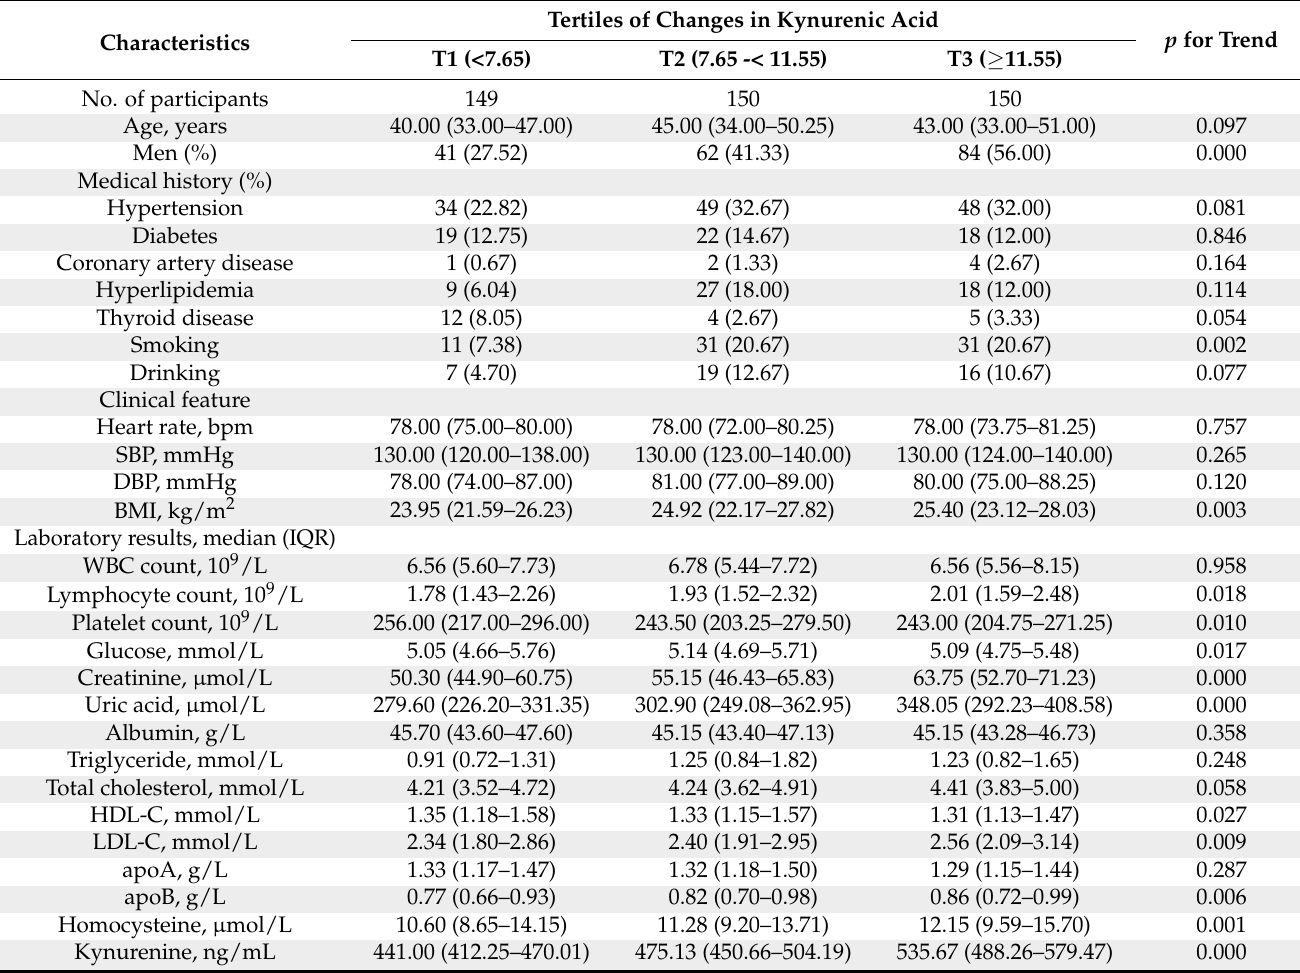
Table 2. Baseline characteristics of participants according to tertiles of changes in kynurenic acid.